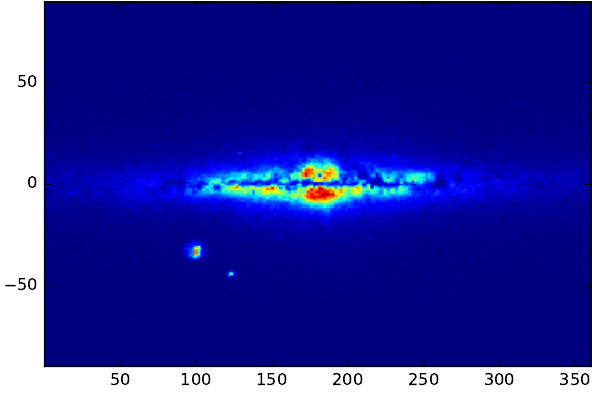
Fig. 96.— Plot of Gaia stars, retrieved with PyVO resulting image gaia-plot.pdf can be seen in Fig. 96. Once more, the Milky Way, the Large Magellanic Cloud and the Small Magellanic Cloud are clearly